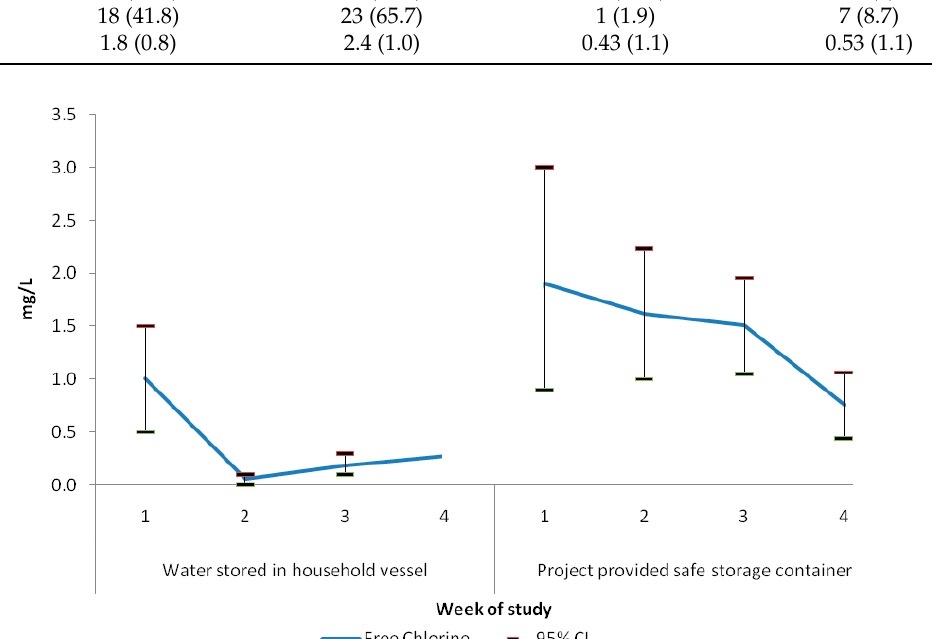
Figure 1. Weekly free residual chlorine in household storage containers ( n = 80) and project ‐ pro ‐ vided safe storage containers ( n = 32) during follow ‐ up visits in FDMN camps, Cox’s Bazar,